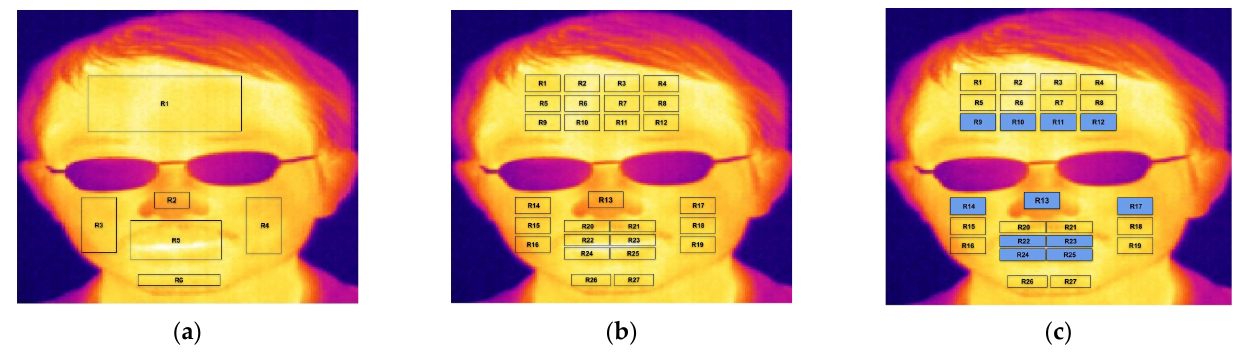
Figure 3. Selection of ROIs for three proposed classification models: ( a ) represents 6 main ROIs, ( b ) represents 27 sub-ROIs decomposed from 6 main ROIs, ( c ) represents selective 11 sub-ROIs from 27 sub-ROIs.